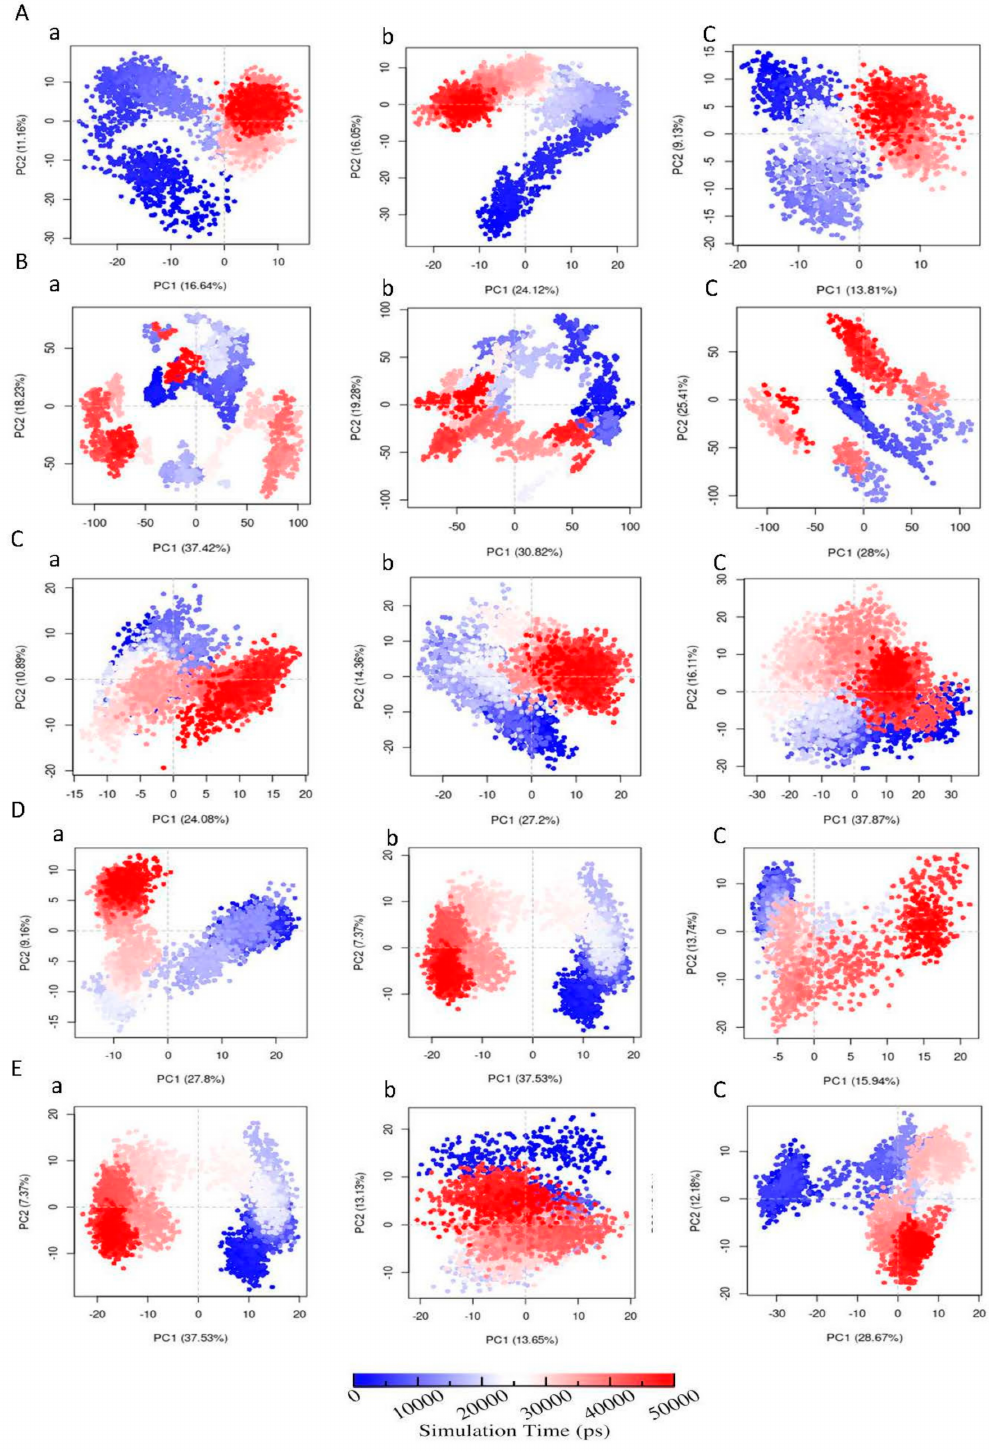
Figure 10. Plot of PC1 versus PC2 of ( A ) ( a ) AChE-FM, ( b ) AChE-FMS, ( c ) AChE; ( B ) ( a ) AMPK-FN, ( b ) AMPK-FNS, ( c ) AMPK; ( C ) ( a ) ASK1-FM, ( b ) ASK1-FMS, ( c ) ASK1; ( D ) ( a ) GST-IM, ( b ) GST-6-CIPHD, ( c ) GST; and ( E ) ( a ) PKC-IM, ( b ) PKC-6-CIPHD, ( c ) PKC. The color of the PCA plot change from blue to red as the complex evolves with